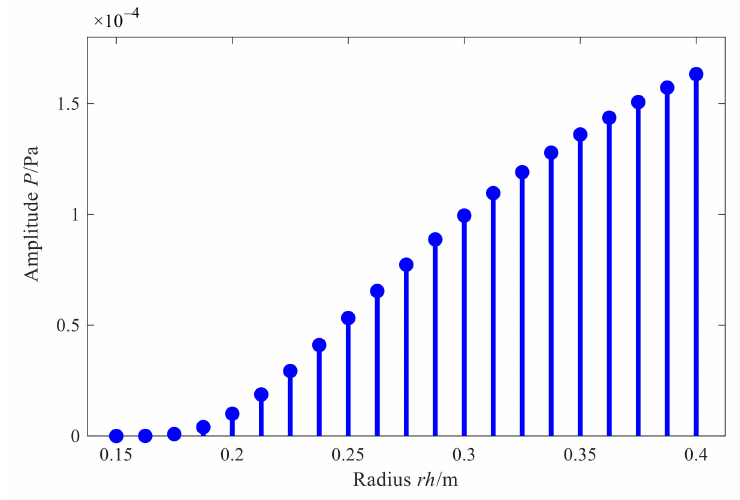
Figure 6. Amplitude variation of Φ β